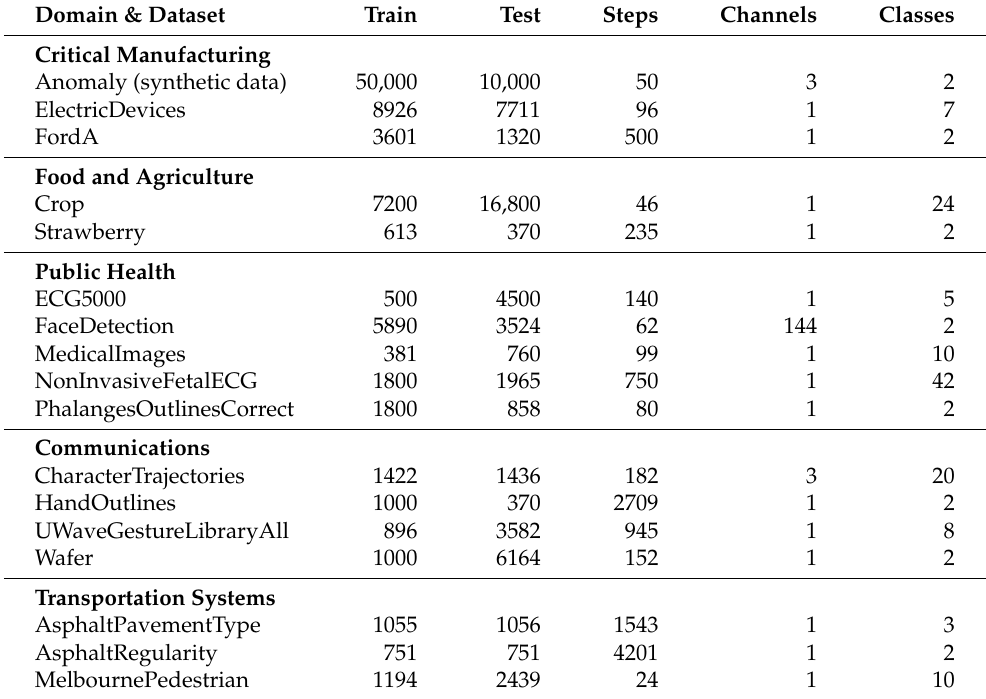
Table 1. Datasets related to critical infrastructures. Different characteristics such as the datasetsize, length, feature number and classes are covered by this